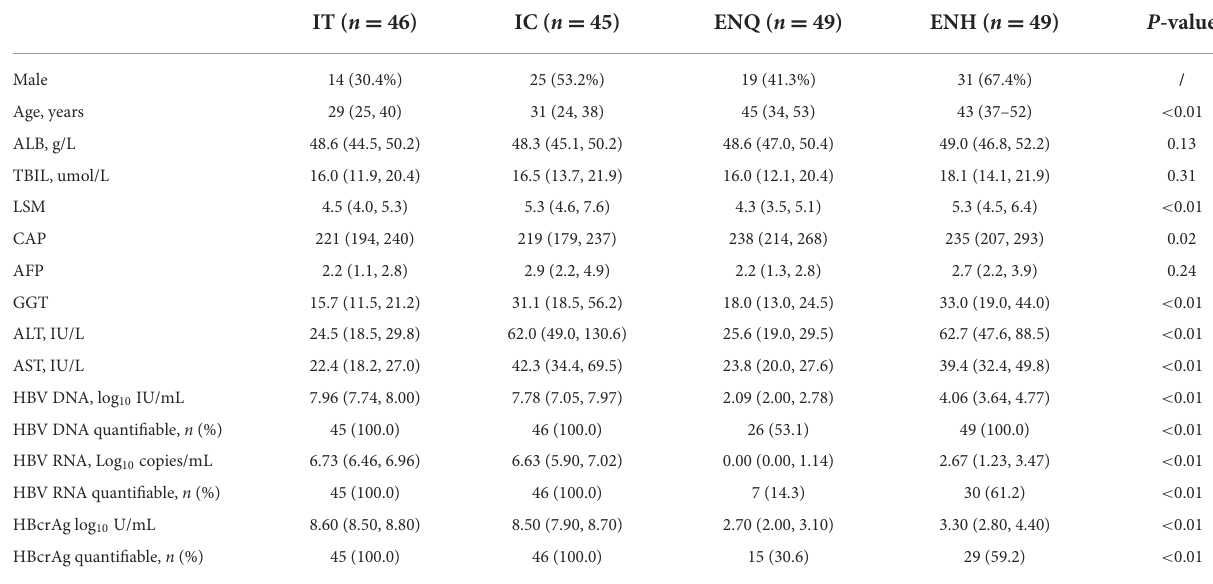
TABLE 1 Clinical characteristics of the patients in this